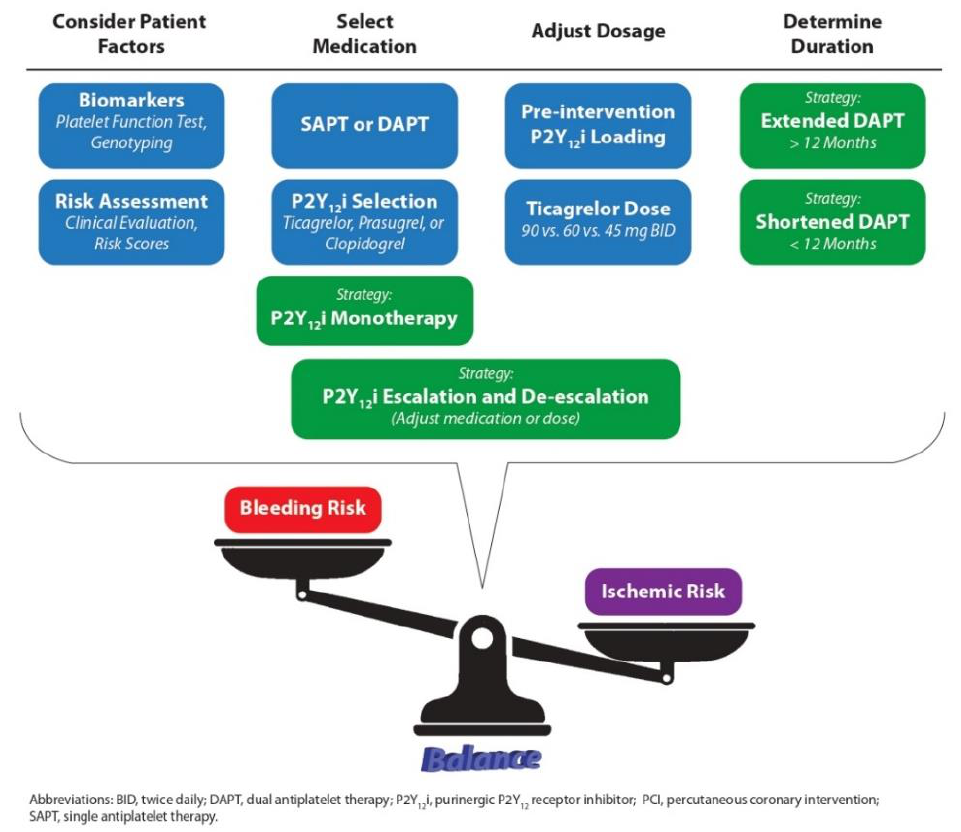
Figure 1. Schematic representation of various important considerations in antiplatelet therapy for patients with acute coronary syndrome or stable coronary artery disease, which have been the subjects of major clinical studies and literature discussions in recent years. Underlying these considerations is the critical notion of balancing ischemic risk and bleeding